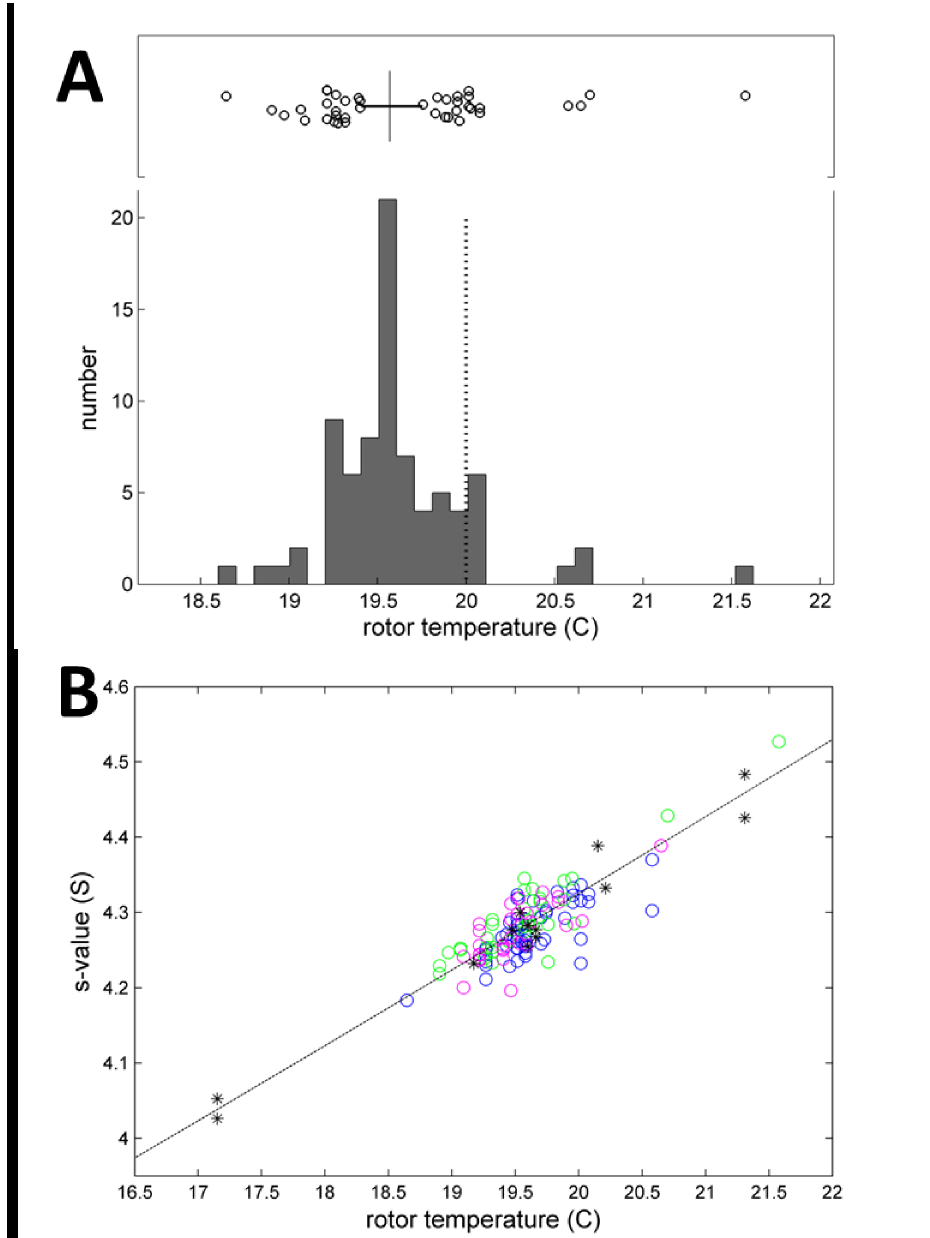
Fig 5. Analysis of the rotor temperature. (A) Temperature values obtained in different instruments of the spinning rotor, as measured in the iButton at 1,000 rpm after temperature equilibration, while the set point for the console temperature is 20°C (indicated as dotted vertical line). The box-and-whisker plot indicates the central 50% of the data as solid line, with the median displayed as vertical line, and individual circles for data in the upper and lower 25% percentiles. The mean and standard deviation is 19.62°C ± 0.41°C. (B) Correlation between iButton temperature and measured BSA monomer s -values corrected for radial magnification, scan time, scan velocity, but not viscosity (symbols). In addition to the data from the present study as shown in (A) (circles), also shown are measurements from the pilot study [27] where the same experiments were carried out on instruments not included in the present study (stars). The dotted line describes the theoretically expected temperature-dependence considering solvent